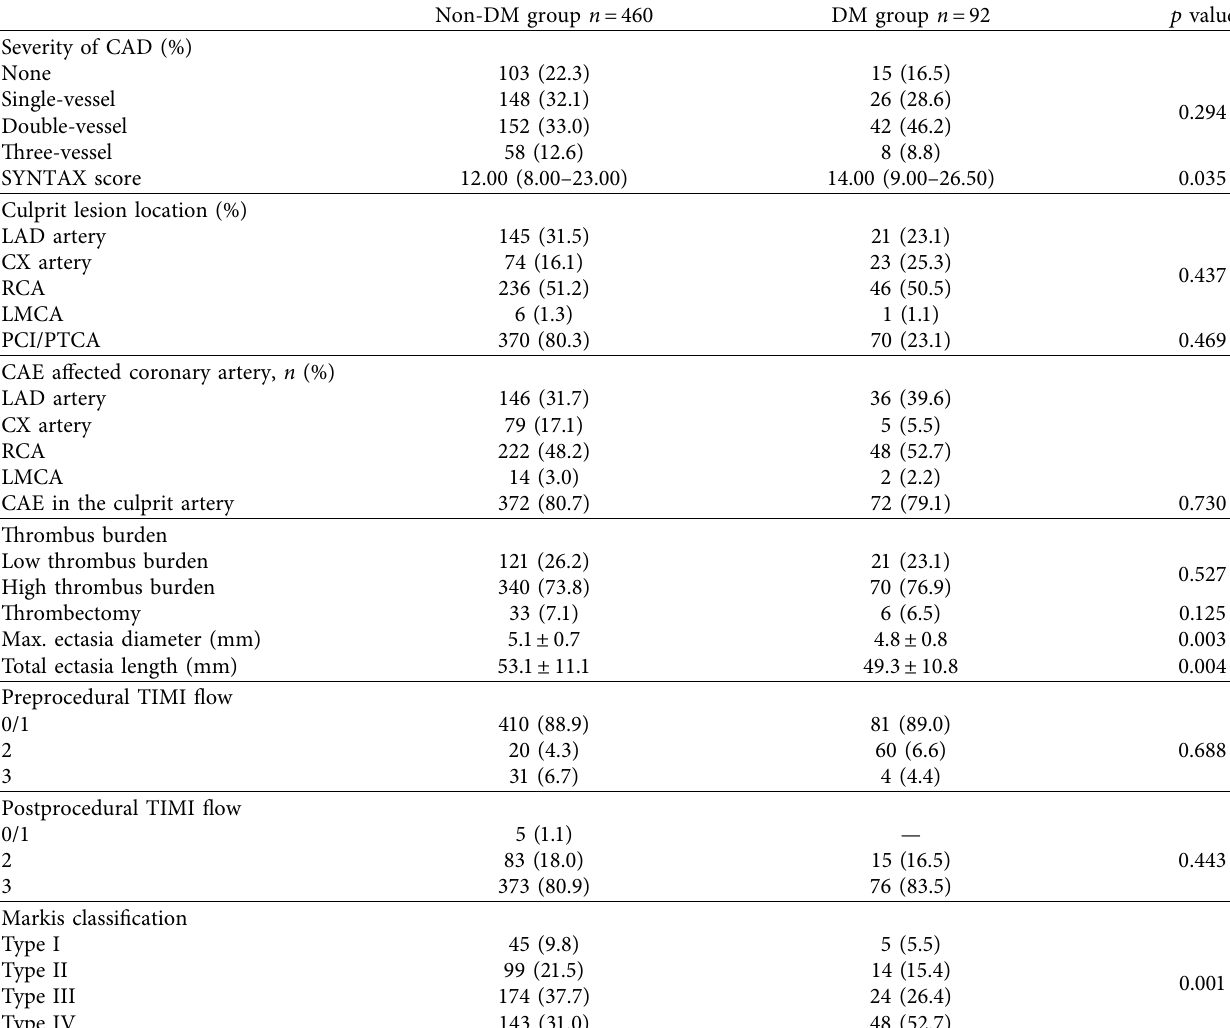
Table 4: Angiographic characteristics of coronary artery ectasia patients according to their diabetic